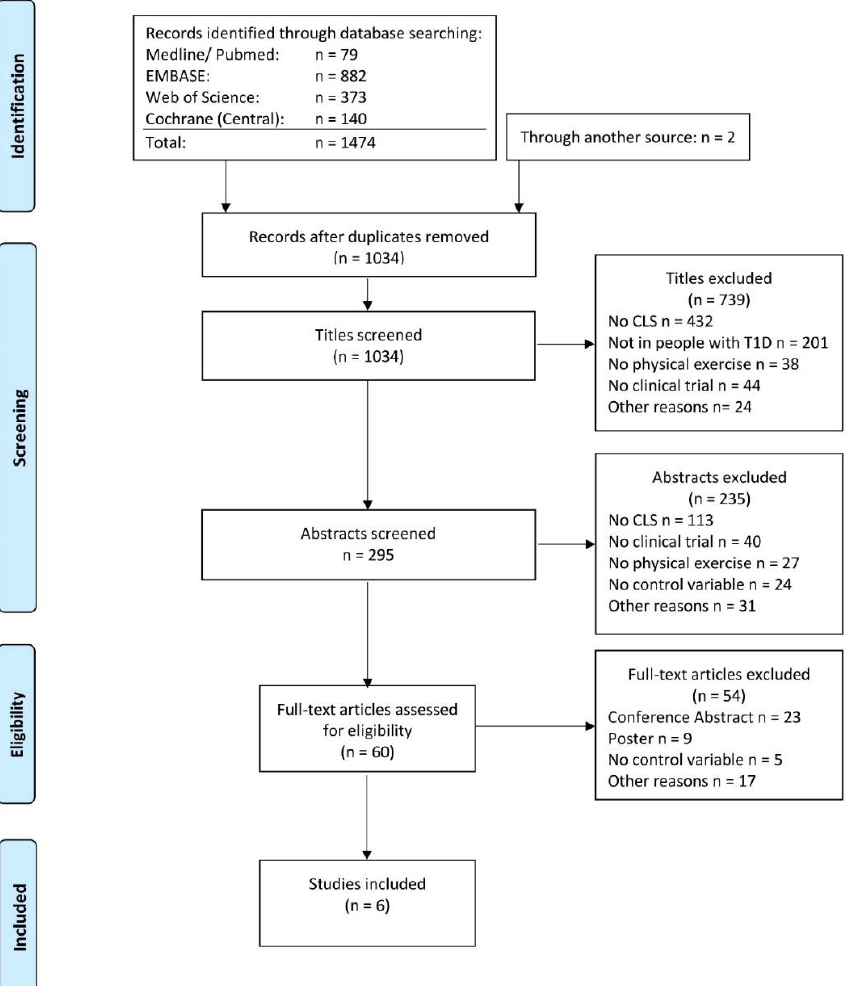
Figure 2. Prisma flow diagram (accessed on, 27th of July 2020).